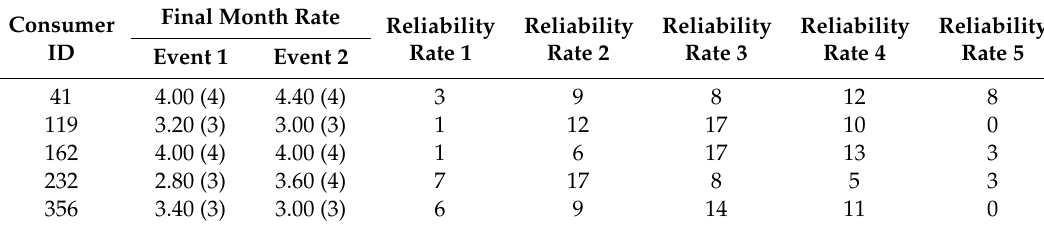
Table 11. Final Reliability Rate from selected consumers when using Method